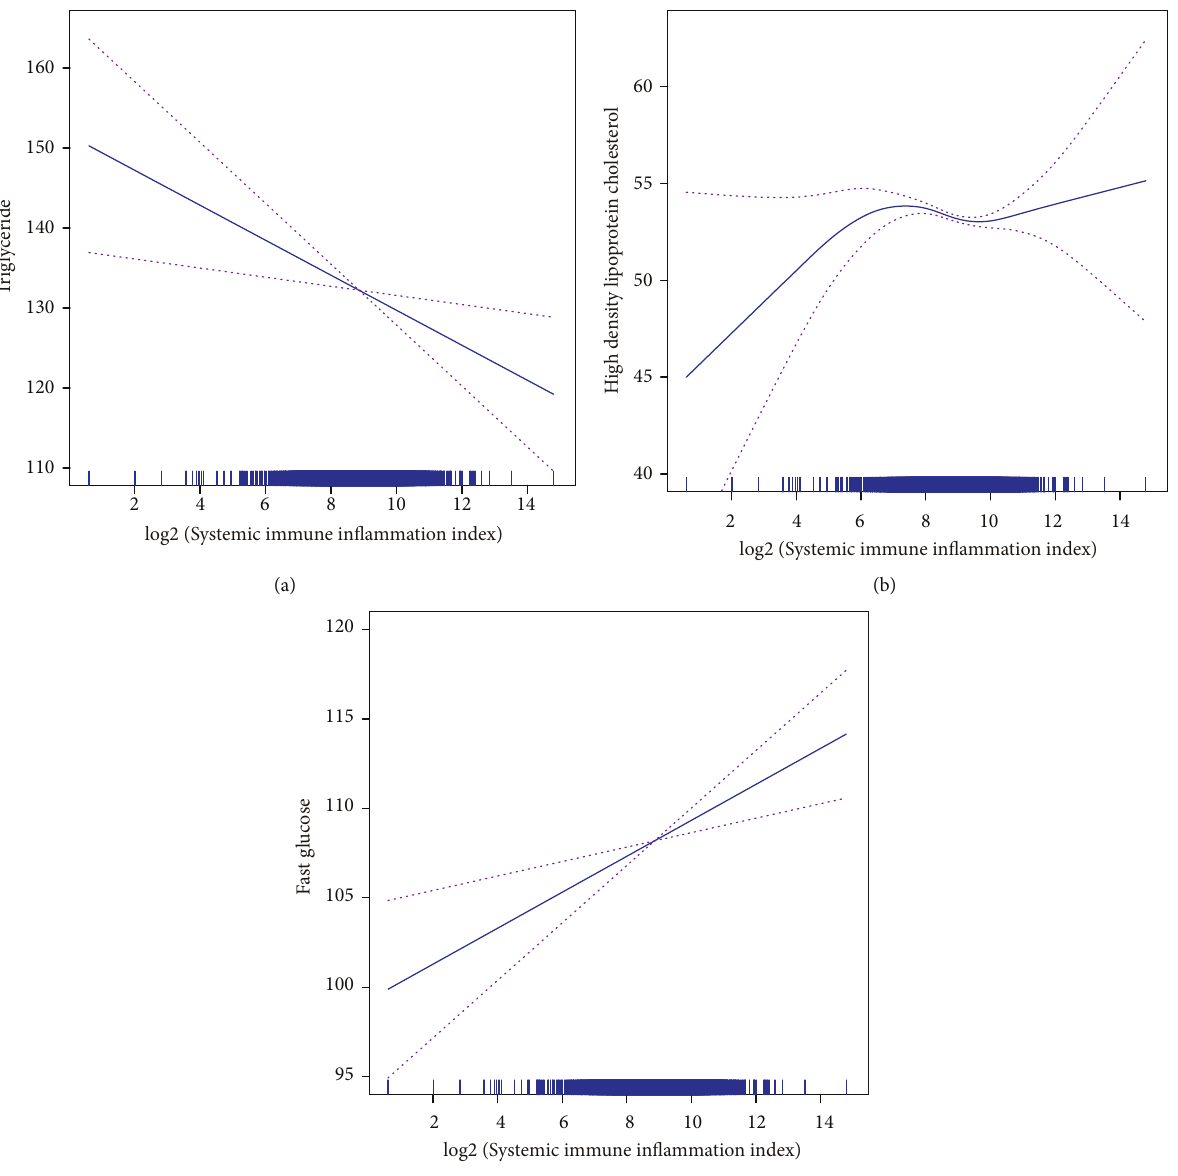
Figure 2: The generalized additive models of the association between SII index with (a) triglyceride, (b) high-density lipoprotein cholesterol, and (c) fast glucose. Abbreviation: SII: systemic immune in fl